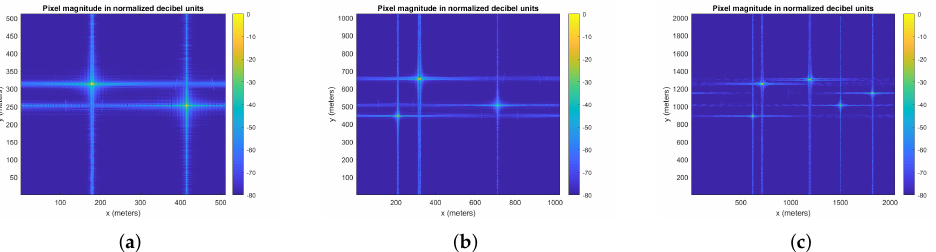
Figure 15. Images generated using the polar format algorithm with range interpolation with the PER- FECT dataset (sizes small, medium and large). ( a ) Perfect dataset image (size small) generated using the polar format algorithm with range interpolation. ( b ) Perfect dataset image (size medium) generated using the polar format algorithm with range interpolation. ( c ) Perfect dataset image (size large) generated using the polar format algorithm with range interpolation.